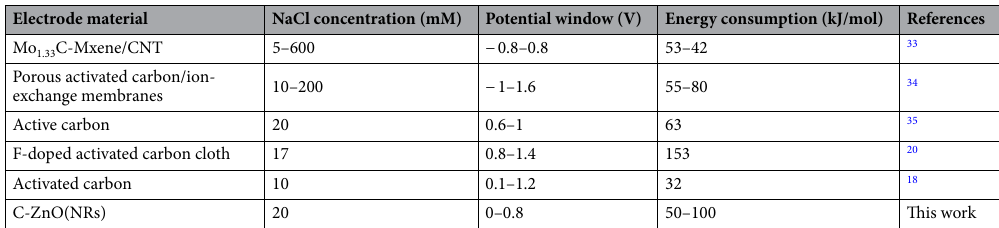
Table 1. Comparison of energy consumption of different electrode